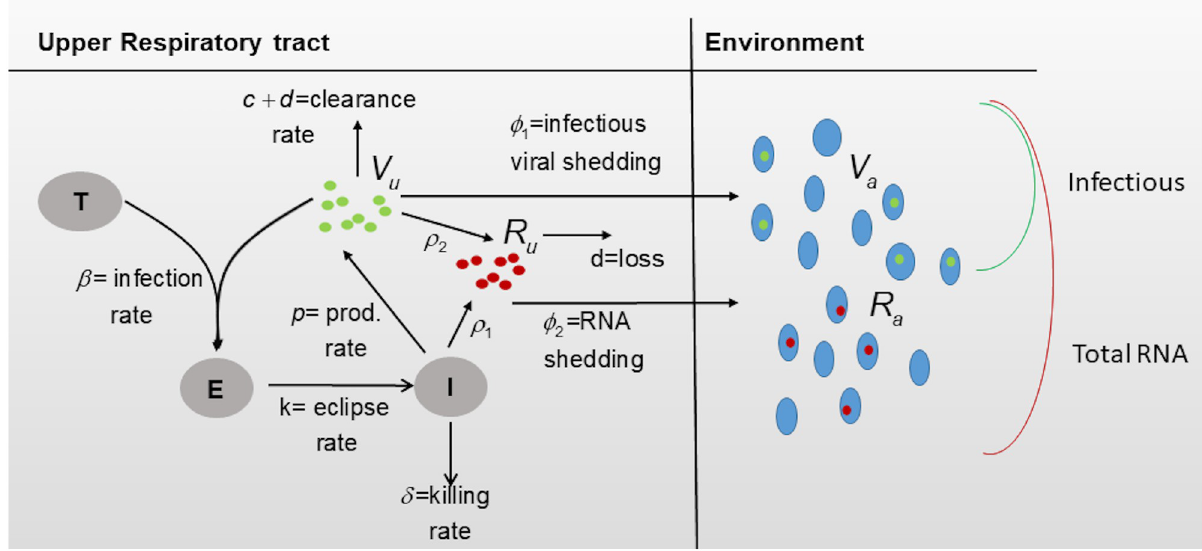
Fig 1. Model diagram. Diagram for model Eqs (3) and